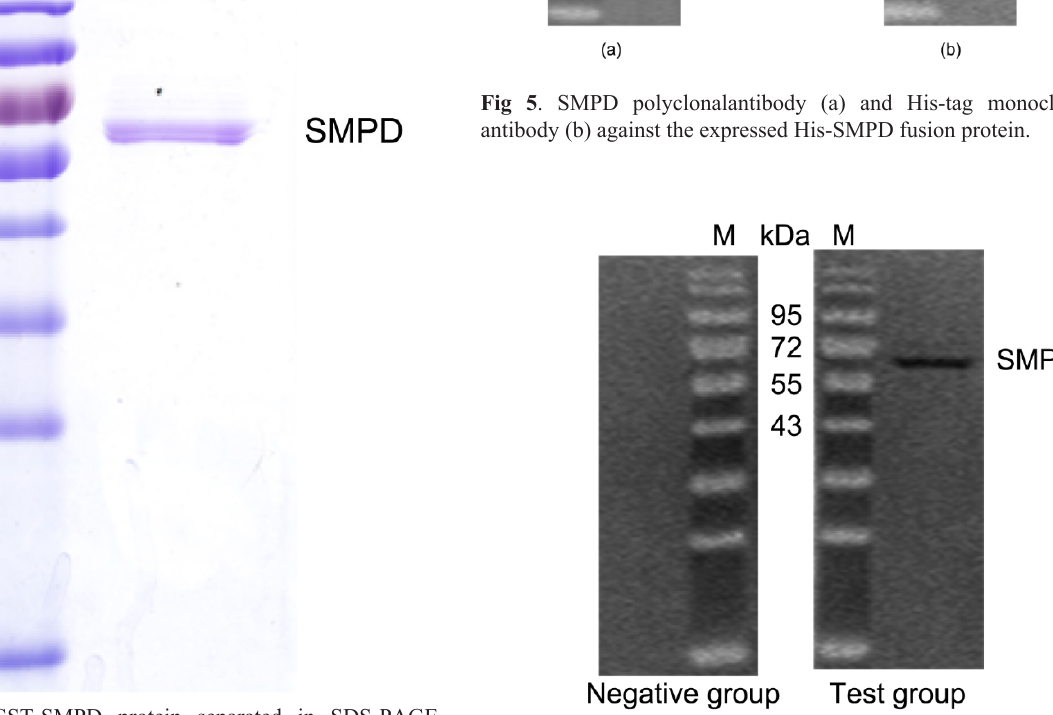
Fig 6 . Polyclonal antibody and negative antiserum hybrid with bumblebee total protein using western